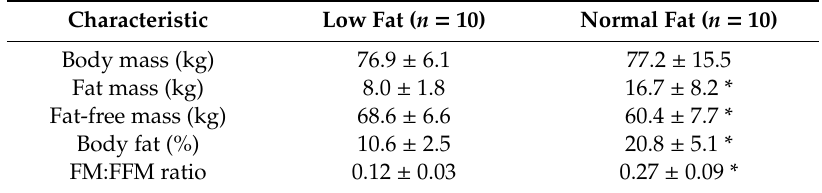
Table 1. Anthropometric characteristics (mean ± standard deviation) and comparison of low- and normal-fat